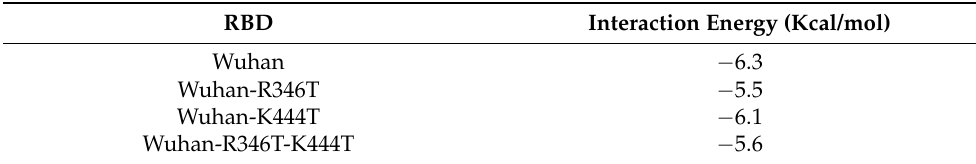
Table 2. Interaction energy between Wuhan and mutant RBDs and the CV38-142 antibody-heavy chain calculated by Foldx5. RBD Interaction Energy (Kcal/mol) Wuhan − 6.3 Wuhan-R346T − 5.5 Wuhan-K444T − 6.1 Wuhan-R346T-K444T − 5.6